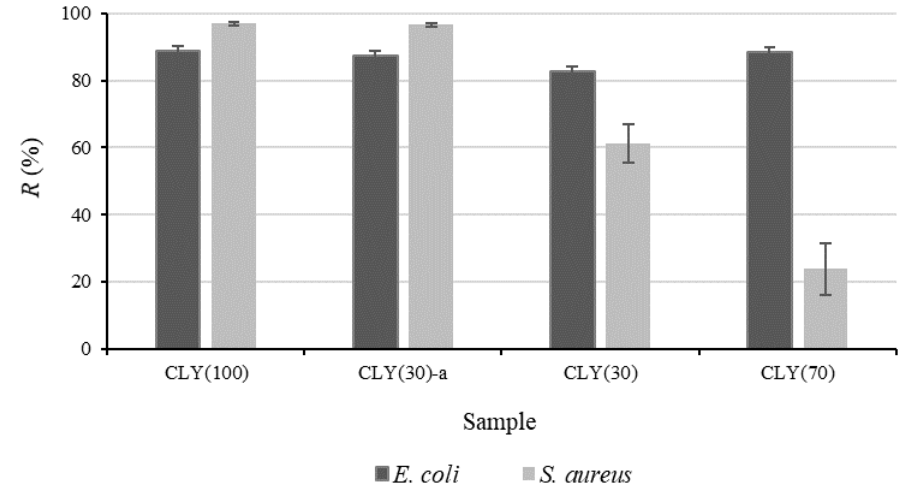
Figure 3. Reduction, R , of E. coli and S. aureus for single CLY fibers (sample CLY(100)) and the fiber blended samples. The K sample was used as a reference for the CLY(30) and CLY(70) samples and the CV(100) sample was used as a reference for the CLY(100) and CLY(30)-a samples.